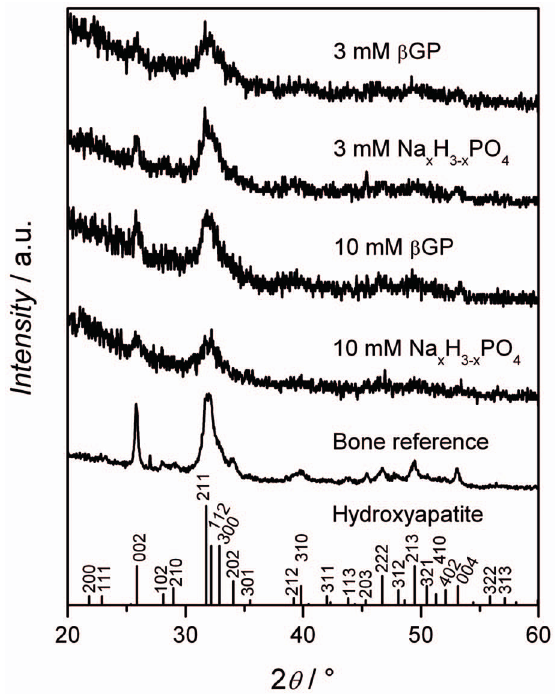
Figure 5. XRD patterns. XRD patterns of cells after osteogenic differentiation for 28 days supplemented with different sources of phosphate. Additionally, a fragment of human hip bone has been used as a reference sample of human bone. With second-derivation curve fitting analysis discrete reflections at 25.9 (002), 31.77 (211), 32.18 (112), 32.9 (300), 34.04 (202), and 39.79 u (310) were detected for all samples supplemented with phosphate as well as for the bone reference sample. These reflections correspond to prominent peaks of hydroxy- apatite [50].